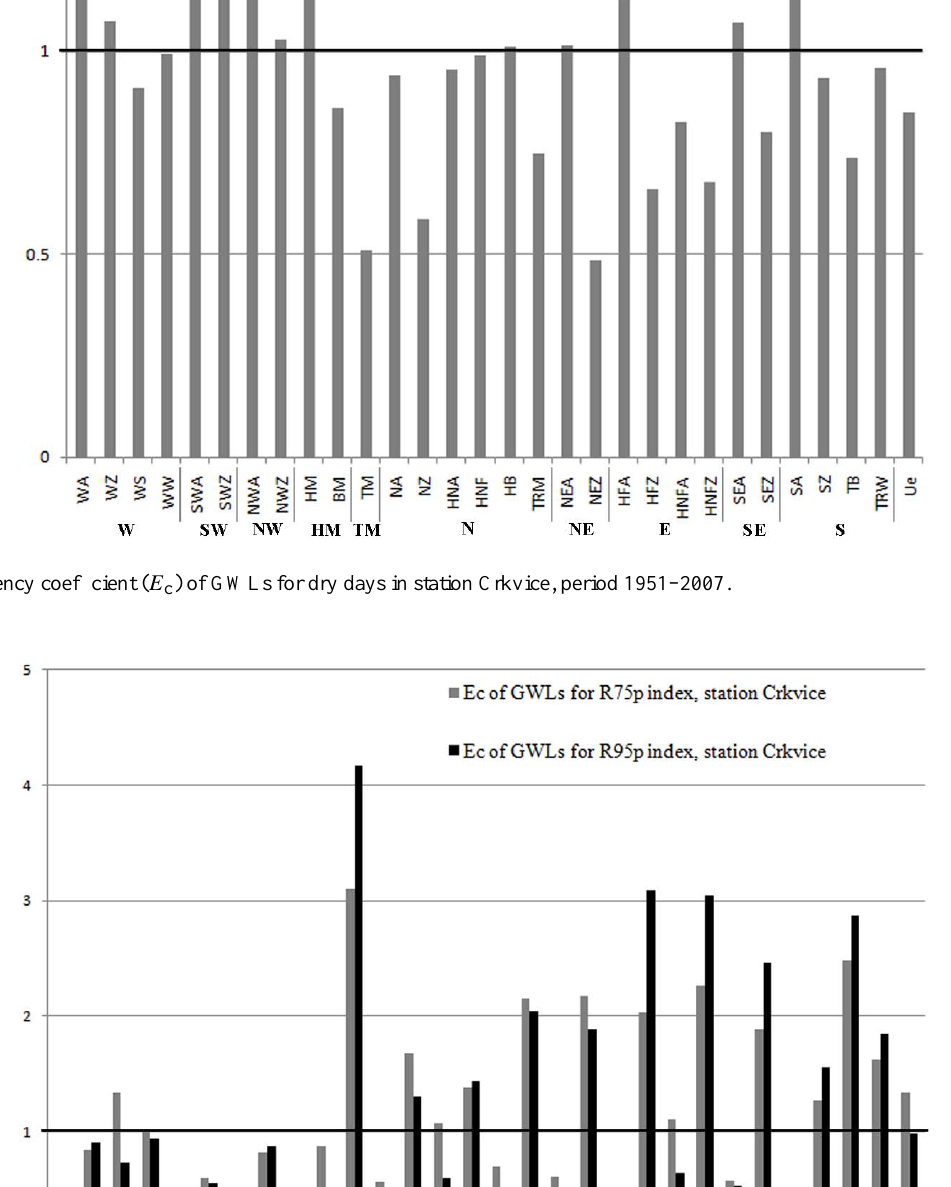
Nat. Hazards Earth Syst. Sci., 12, 687–697, 2012